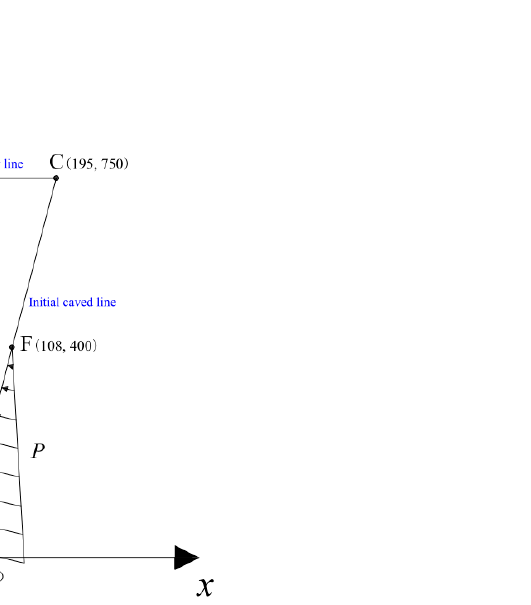
Figure 6. Two-dimensional mechanical model of the open-pit and underground caving combined mining.